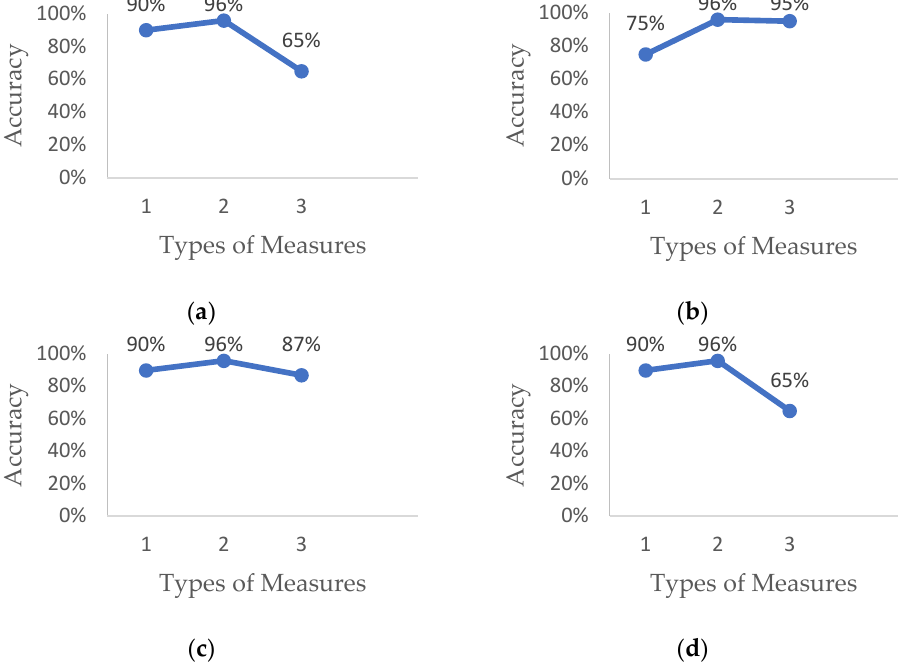
Figure 4. Accuracy of driver drowsiness detection on the basis of different conditions: ( a ) low lighting conditions; ( b ) road conditions; ( c ) driver with beard; ( d ) driver wearing eyeglasses. (1) Vehicle-Based Measure (2) Physiological Measure (3) Behavioral